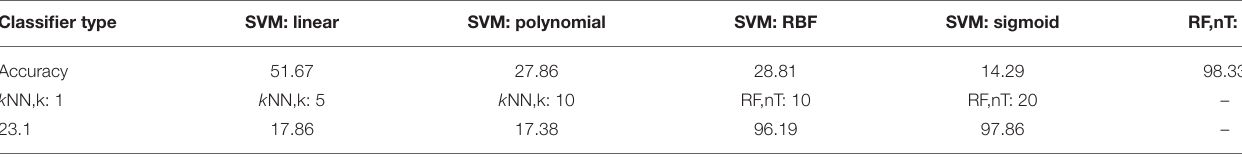
TABLE 10 | Results of experiments to classify Geo features using traditional classifiers.